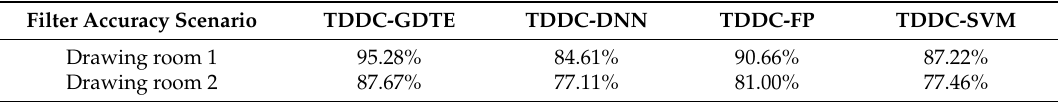
Table 3. The localization accuracy rate of the different localization models with the same TDDC filtering.